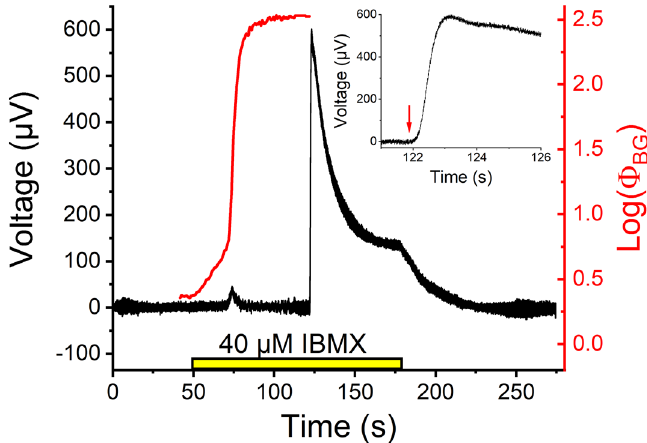
Figure 3. One cGMP clamp run recorded in normal Ca 2+ with LERG-OS. The black trace illustrates the LERG-OS voltage and red trace the background light strength produced by the closed-loop PID-controlled feedback system to keep the LERG-OS voltage steady after the introduction of 40 µM IBMX (yellow bar). After the controller has reached a steady-state, the background light is turned off. This causes a rapid increase in the LERG-OS voltage, which downregulates to a new steady-state after maximal effect of IBMX (the peak voltage increase). After the washout of IBMX, the LERG-OS voltage returns to the baseline level. The inset shows the LERG-OS voltage on an extended time scale around the time of the turn-off of the background light. The red arrow indicates the precise time of the background